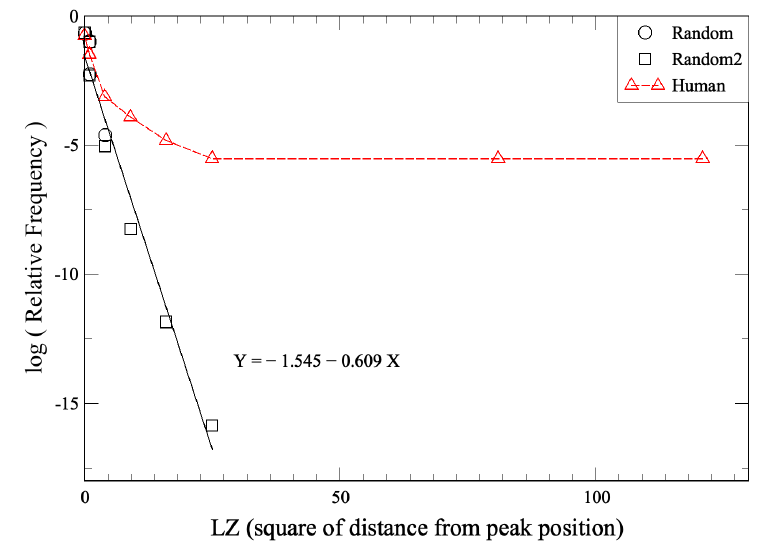
Figure 2. Distribution of relative frequency at different scale. The horizontal axis is the square of distance from the peak value. The results from the pseudorandom series (circle and square black marks) follow a normal distribution. The data are the same as those in Figure